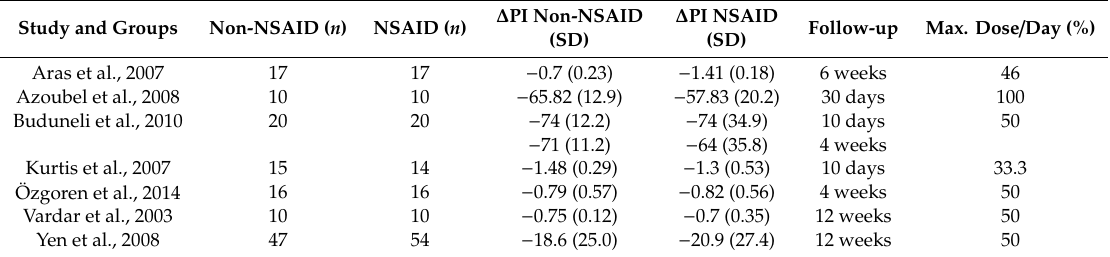
Table 6. Plaque index in comparison of non-NSAID and NSAID